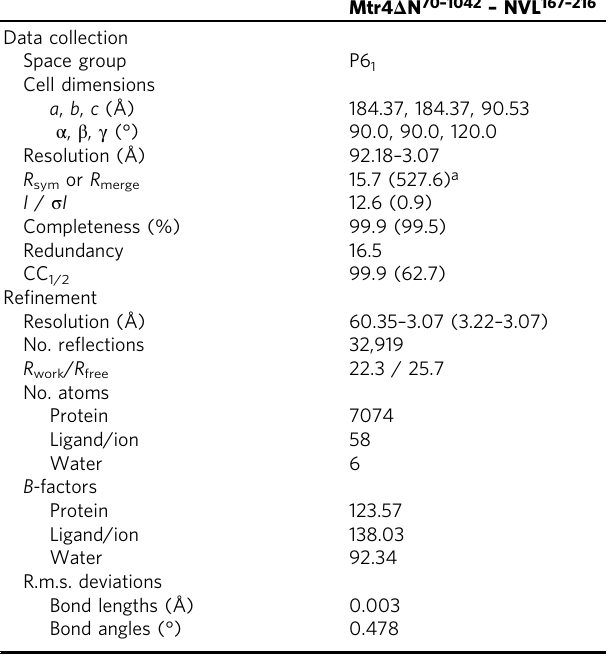
Table 1 Data collection and re fi nement